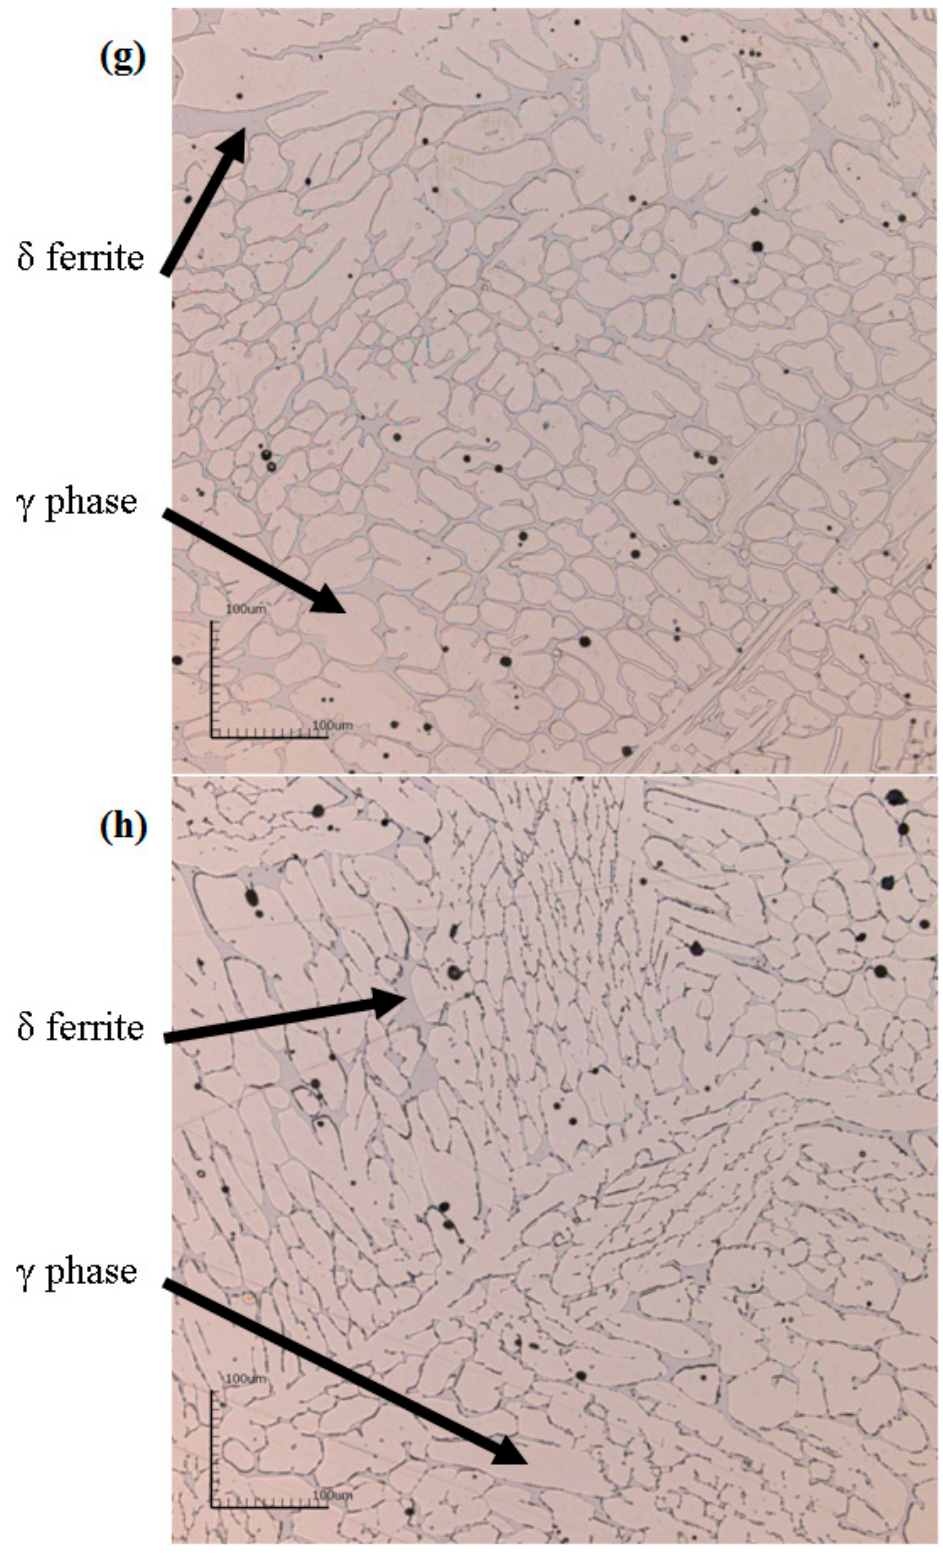
Figure 6. Microstructure evolution of specimens age-treated at 385 ◦ C for various periods of time, ( a ) low ferrite (LF) 0 h; ( b ) LF 2400 h; ( c ) LF 6000 h; ( d ) LF 30,000 h; ( e ) high ferrite (HF) 0 h; ( f ) HF 2400 h; ( g ) HF 6000 h; ( h ) HF 30,000